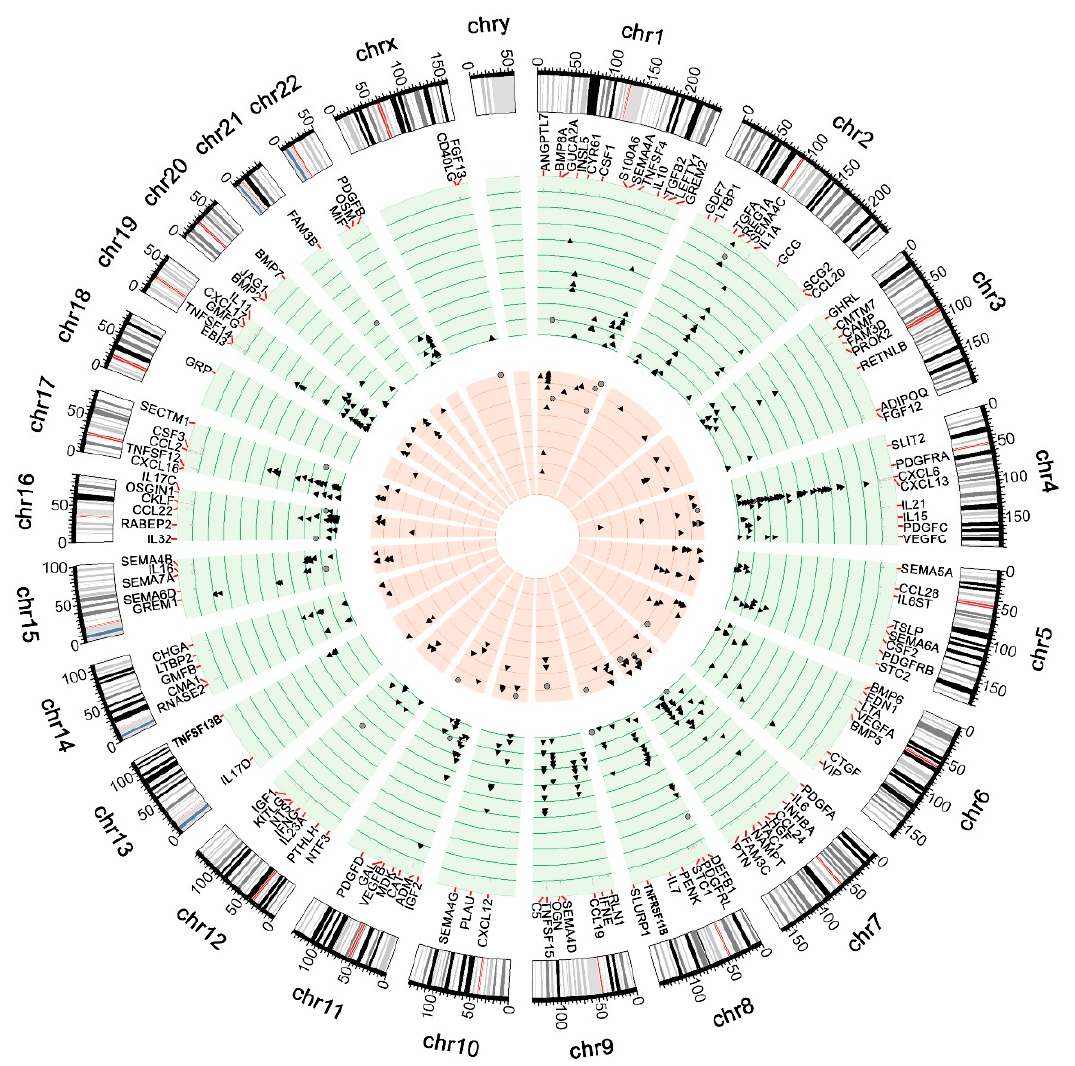
Figure 1. Differential expression profile of ulcerative colitis (triangles) and Crohn’s disease (circles). Green background, up-regulated cytokines; red background, down-regulated cytokines; green axes, logFC between 0.5 and 5; red axes, logFC between − 0.5 and − 4. Table 4. Differentially expressed genes with inverse regulation in ulcerative colitis and Crohn’s dis-